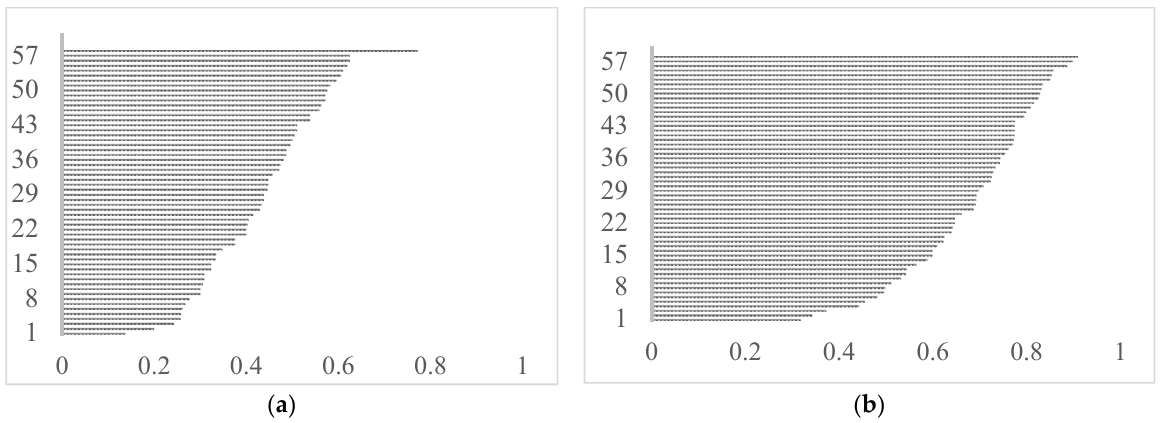
Figure 3. Individual test item facility (means). ( a ) fill-in-the-blanks test; ( b ) multiple-choice test.